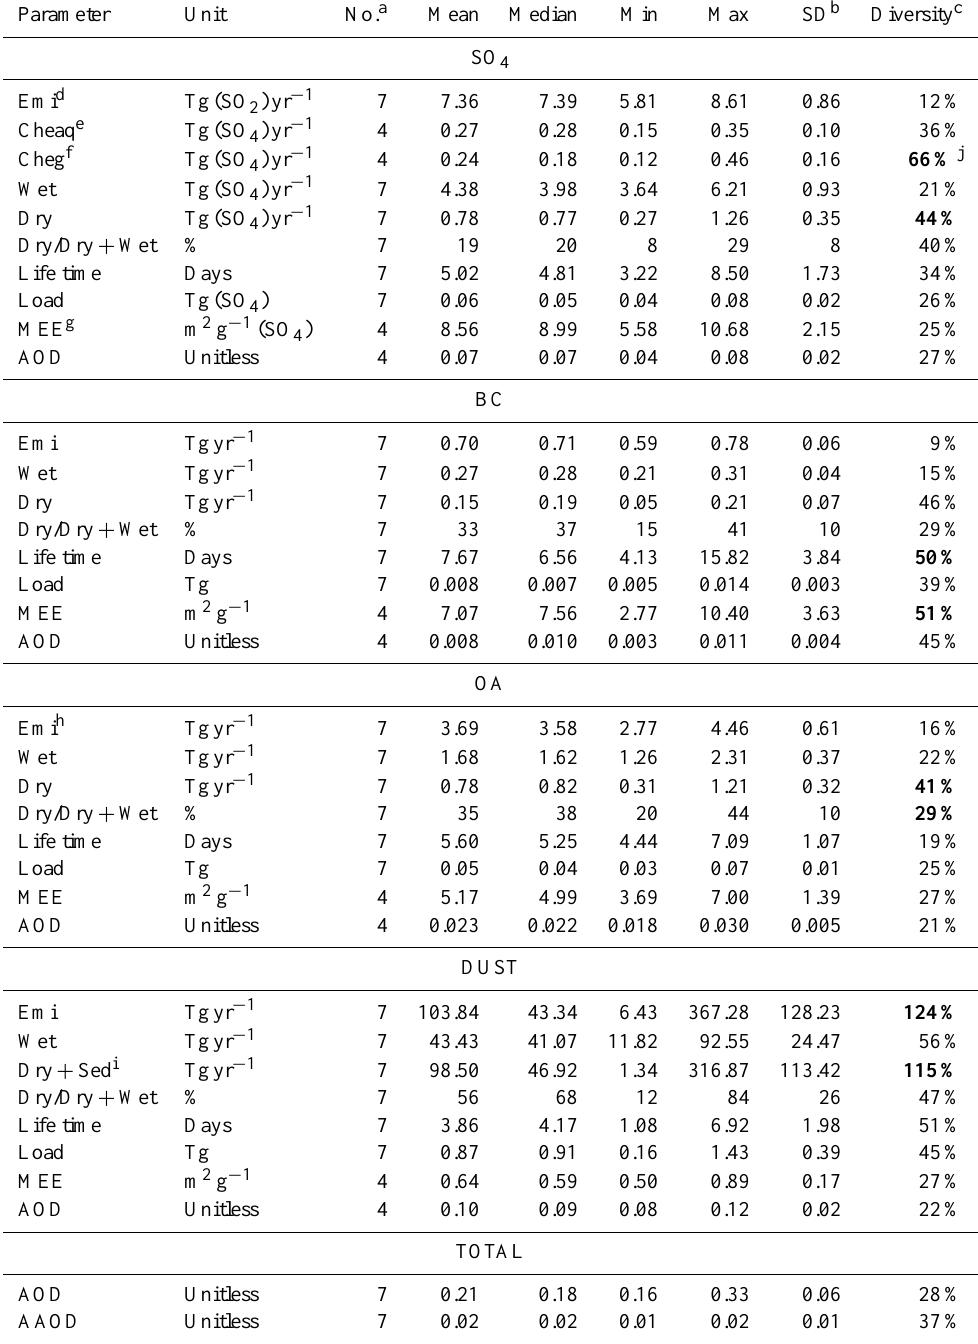
Table 3. The statistics of the aerosol parameters over South Asia (60–95 ◦ E, 5–36 ◦ N; land only) in